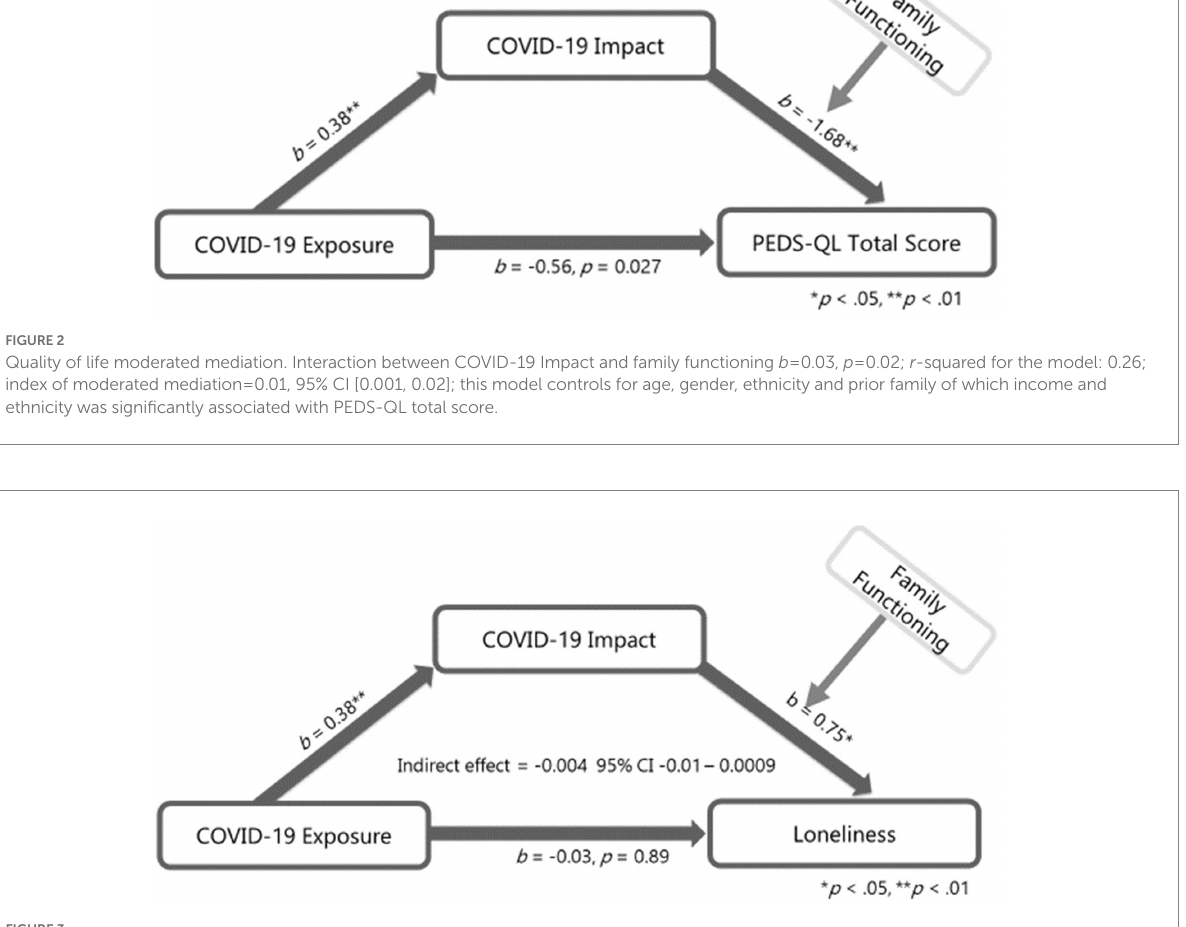
FIGURE 3 Loneliness moderated mediation. Interaction between COVID-19 Impact and family functioning b = − 0.01, p = 0.19; r -squared for the model: 0.30; this model controls for age, gender, ethnicity and prior family income of which gender and age were significantly associated with PEDS-QL total